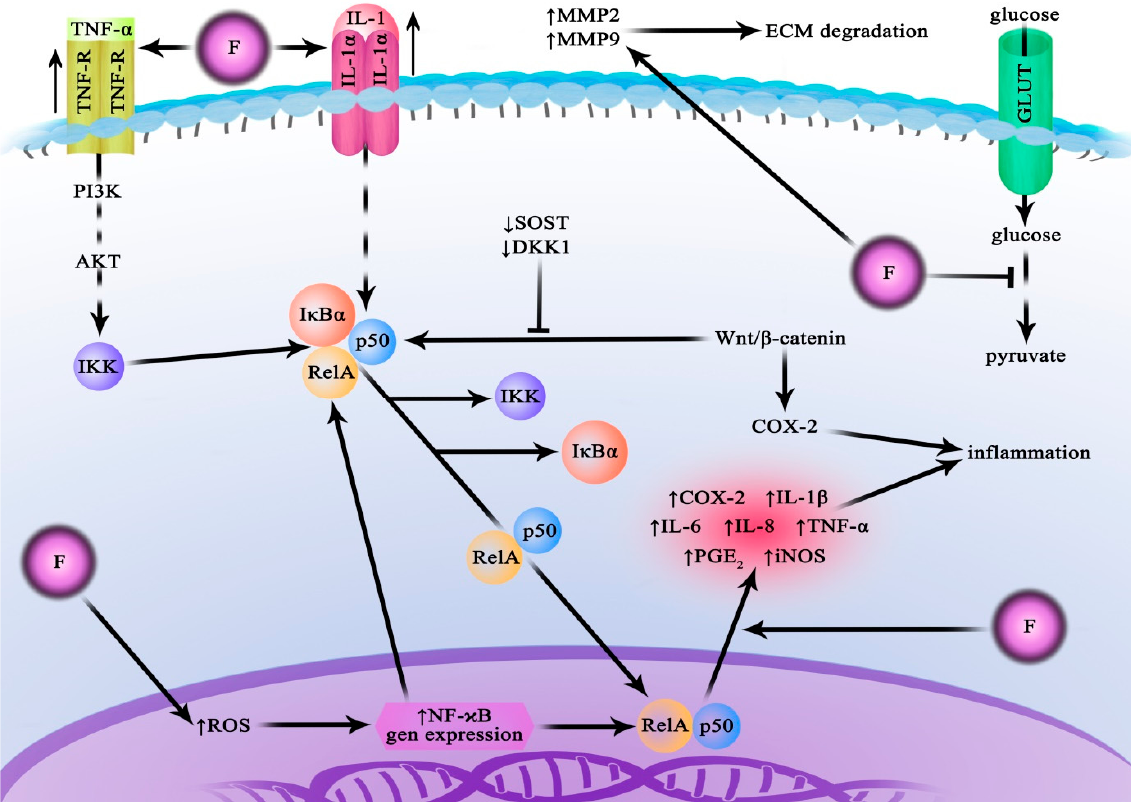
Figure 1. Fluoride action in normal cells. Fluoride affects normal cells in a pro-inflammatory manner, which is associated with the activation of the NF-kB pathway. As an inhibitor of glycolysis enzymes, it leads to disturbances in energy metabolism. AKT—protein kinase